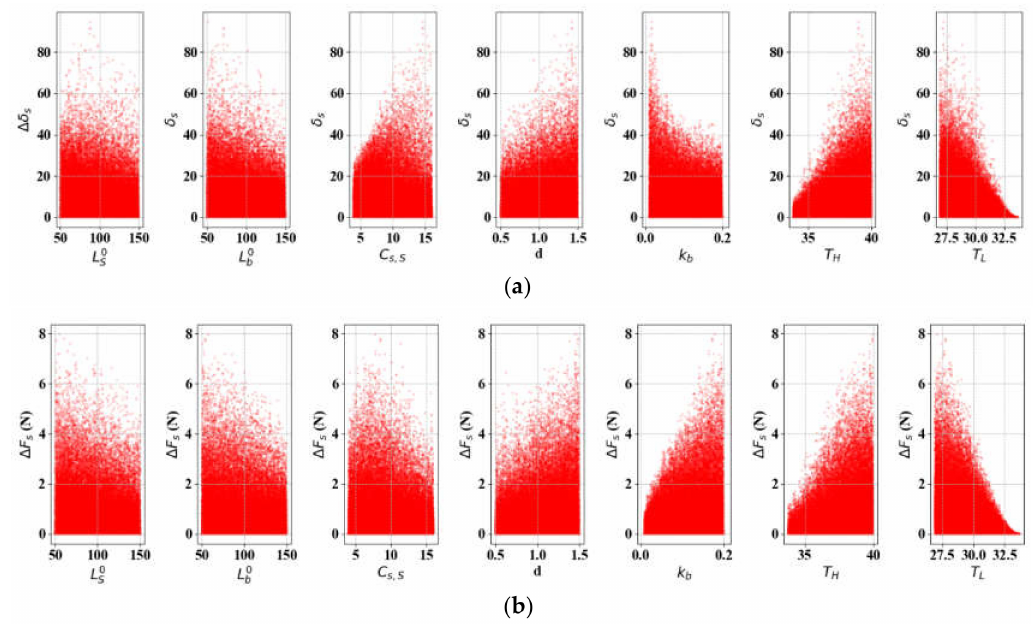
Figure 15. SA results ( L = 300): ( a ) ∆ δ S ; ( b ) ∆ F S . Table 6. Total Sobol indices ( ST ) of ∆ δ S and ∆ F S